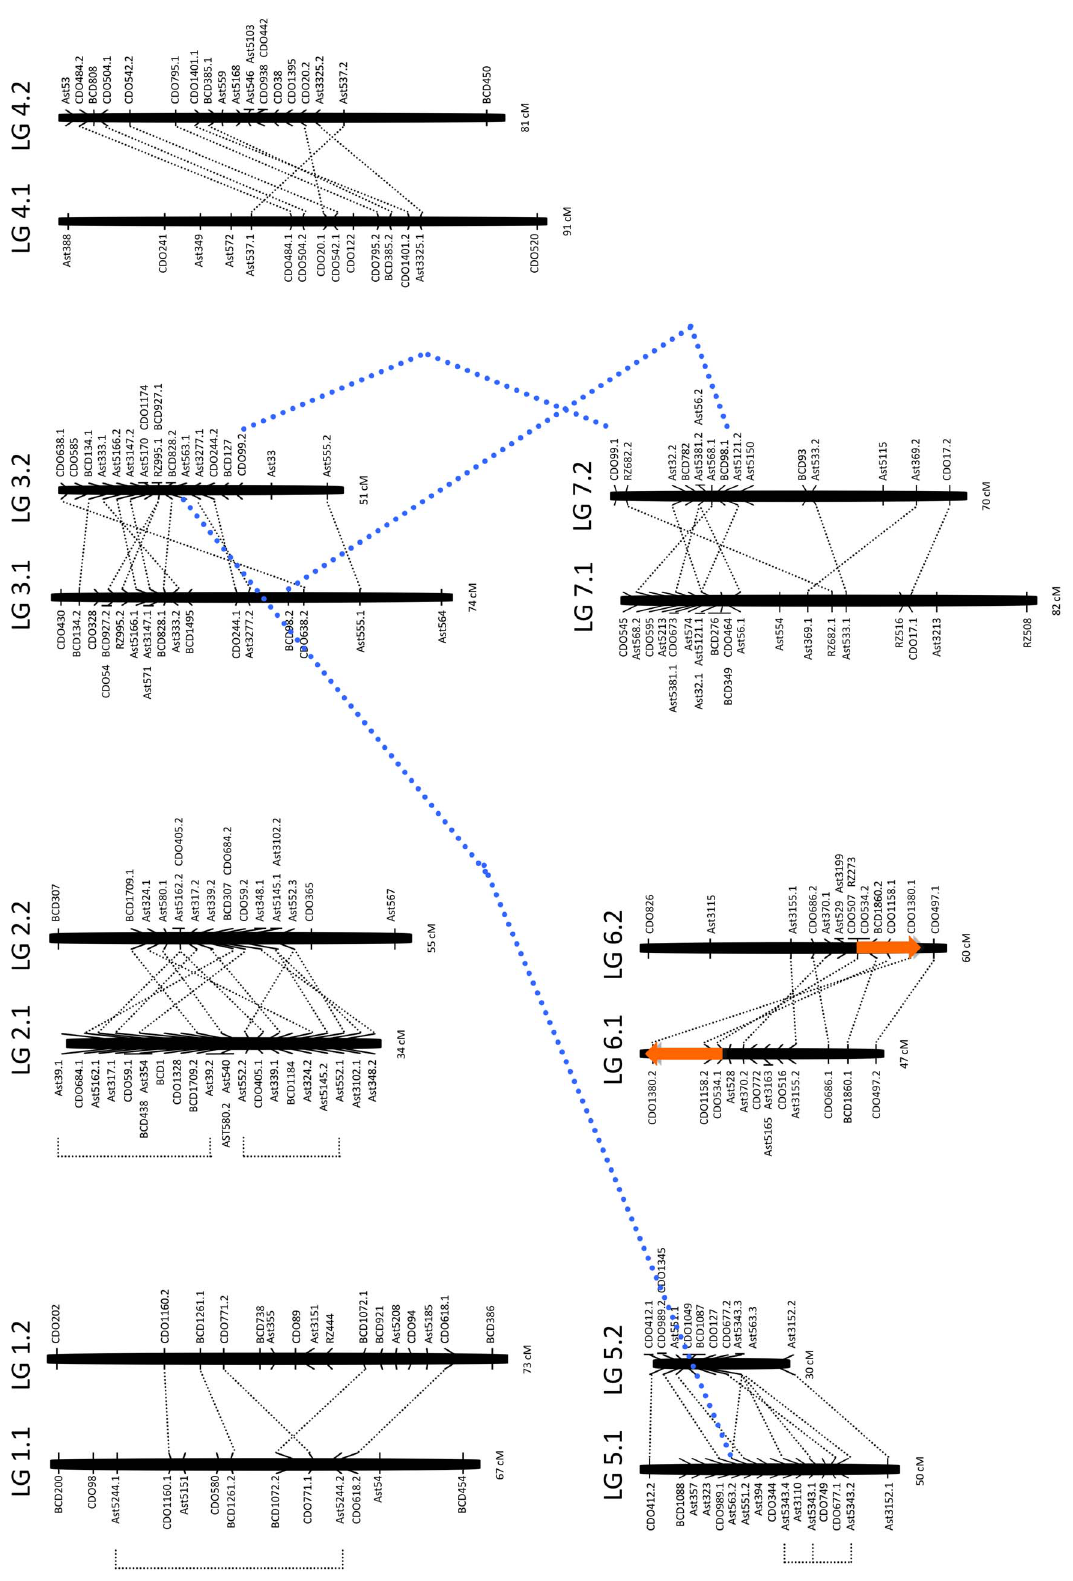
Figure 1. EST-RFLP genetic linkage map of creeping bentgrass. Two different creeping bentgrass diploid genomes are indicated by seven pairs of the homoeologous linkage groups (LGs) followed by ‘‘.1’’ or ‘‘.2’’. The total map length in cM is shown on the bottom of each LG. The creeping bentgrass, barley, oat and rice cDNA probes used as RFLP markers are indicated as Ast, BCD, CDO and RZ, respectively followed by the probe number. The probe numbers plus ‘.1’, ‘.2’, ‘.3’ or ‘.4’ show duplicate loci detected by the same hybridization probe, which are connected by a